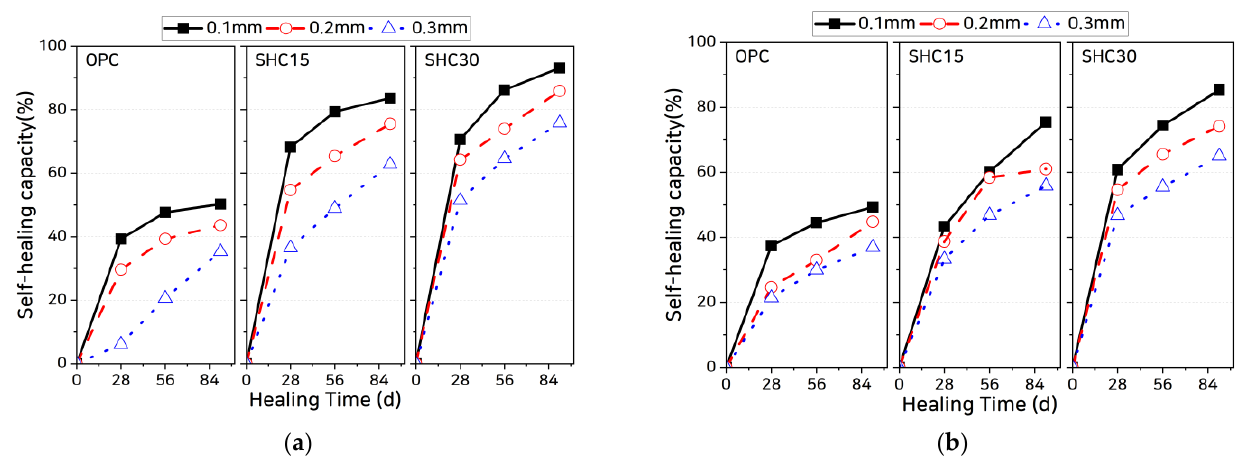
Figure 9. Evaluated self-healing capacities of uncoated and coated specimens: ( a ) uncoated specimens and ( b ) coated specimens.